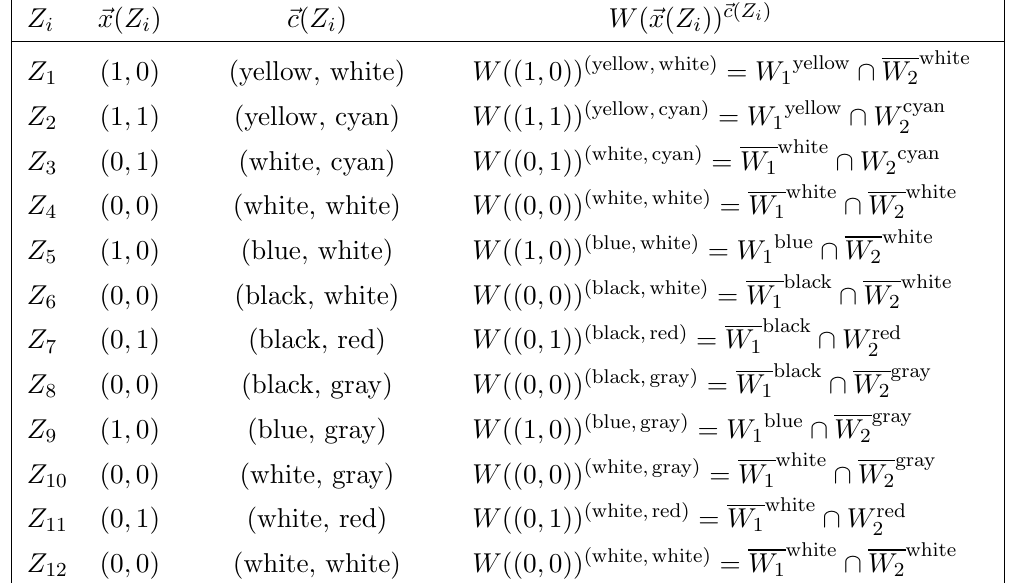
Table 2 . The regions W ( ~x ( Z i )) ~c ( Z i ) , which are contiguous to the boundary, tabulated for